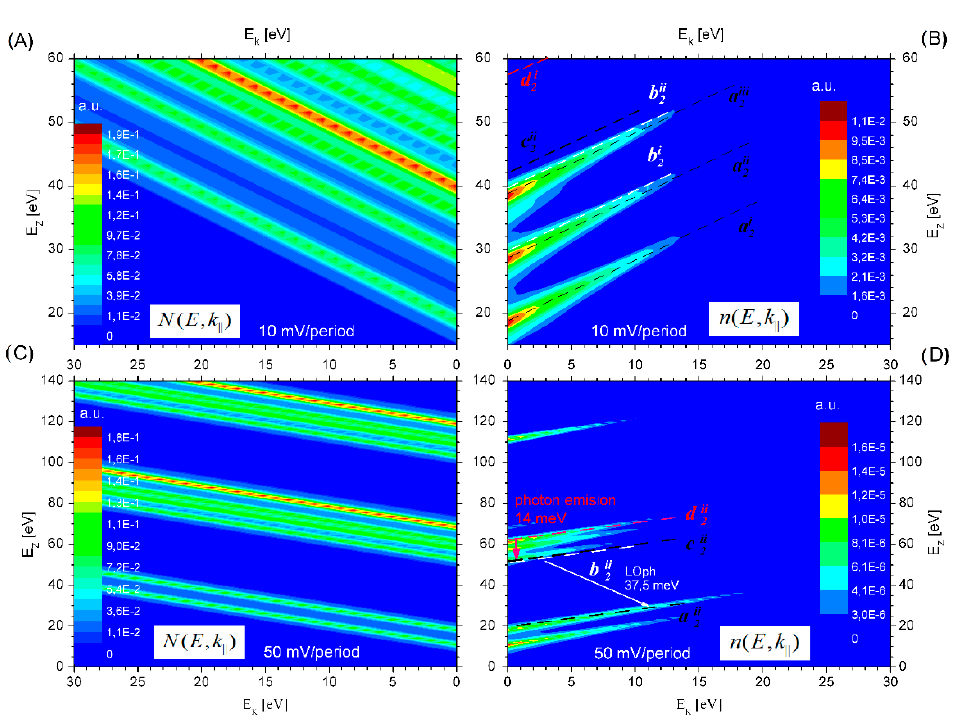
Figure 7. Simulations for the DOS ( N ( E , k || ) ) and the electron density ( n ( E , k || ) ) functions in the kEN ) and the electron density ( ),( kEn ) functions in the Figure 7. Simulations for the DOS ( ),( || || energy space of the wave vector k . The calculations were performed for structure 2 with NEGF and energy space of the wave vector k . The calculations were performed for structure 2 with NEGF the quantum state base of the FMSL, for temperature T = 77 K. Graphs ( A , B ) correspond to voltage U and the quantum state base of the FMSL, for temperature T = 77 K. Graphs (A) and (B) correspond = 10 mV per period, whereas graphs ( C , D ) refer to the voltage U = 50 mV per period. to voltage U = 10 mV per period, whereas graphs (C) and (D) refer to the voltage U = 50 mV per period. Maps of DOS ( N ( E , k || ) ) and occupation by electrons ( n ( E , k || ) ) functions in the energy space of the wave vector k are also presented. The calculations run at the assumed tempera- kEN ) and occupation by electrons ( ),( kEn ) functions in the Maps of DOS ( ),( || || ture T = 77 K. The graphs (A) and (B) were made for the bias voltage of U = 10 mV/period, energy space of the wave vector k are also presented. The calculations run at the as- while the graphs (C) and (D) are related to the voltage U = 50 mV/period. By analyzing the sumed temperature T = 77 K. The graphs (A) and (B) were made for the bias voltage of U results, it can be concluded that for a small voltage applied to the structure (10 mV/period) = 10 mV/period, while the graphs (C) and (D) are related to the voltage U = 50 we observe a high density of states in the energy range corresponding to their eigen energies mV/period. By analyzing the results, it can be concluded that for a small voltage applied (see Figure 6B). Electrons occupy only the lowest states ( a and b ) and there is no visible 2 2 to the structure (10 mV/period) we observe a high density of states in the energy range → c inversion of occupations opening the possibility for photons emission (transitions d ), 2 2 corresponding to their eigen energies (see Figure 6B). Electrons occupy only the lowest → a or phonons (transitions d ). The situation is different for the superlattice biased with 2 2 states ( a and b ) and there is no visible inversion of occupations opening the possibil- voltage of 50 mV/period (see Figure 7D). The higher energy states (e.g., d ii ) show then a 2 2 2 ity for photons emission (transitions cd → ), or phonons (transitions ad → ). The greater occupation than the mid-states ( b ii ), so electronic transitions emitting photons 22 22 2 situation is different for the superlattice biased with voltage of 50 mV/period (see ) show then a greater occupation than the D). The higher energy states (e.g. ii d 2 mid-states ( ii b ), so electronic transitions emitting photons with an energy of 14 meV may 2 occur. Additionally, transitions in the k -vector space emitting optical phonons with an energy of 37.5 meV are also likely to occur. More detailed research with NEGF applied in this area was published earlier [23,29]. This article has been aimed at testing the correctness of a newly developed compu- tational module, whose main task is to effectively find self-consistent potential and charge in a biased voltage SL structure. For this purpose, simulations for typical SL structures were carried out, the results of which are presented in Figure 7 Graph (A) shows the re- sults of a self-consistent solution for the Schrödinger and Poisson equations with regards